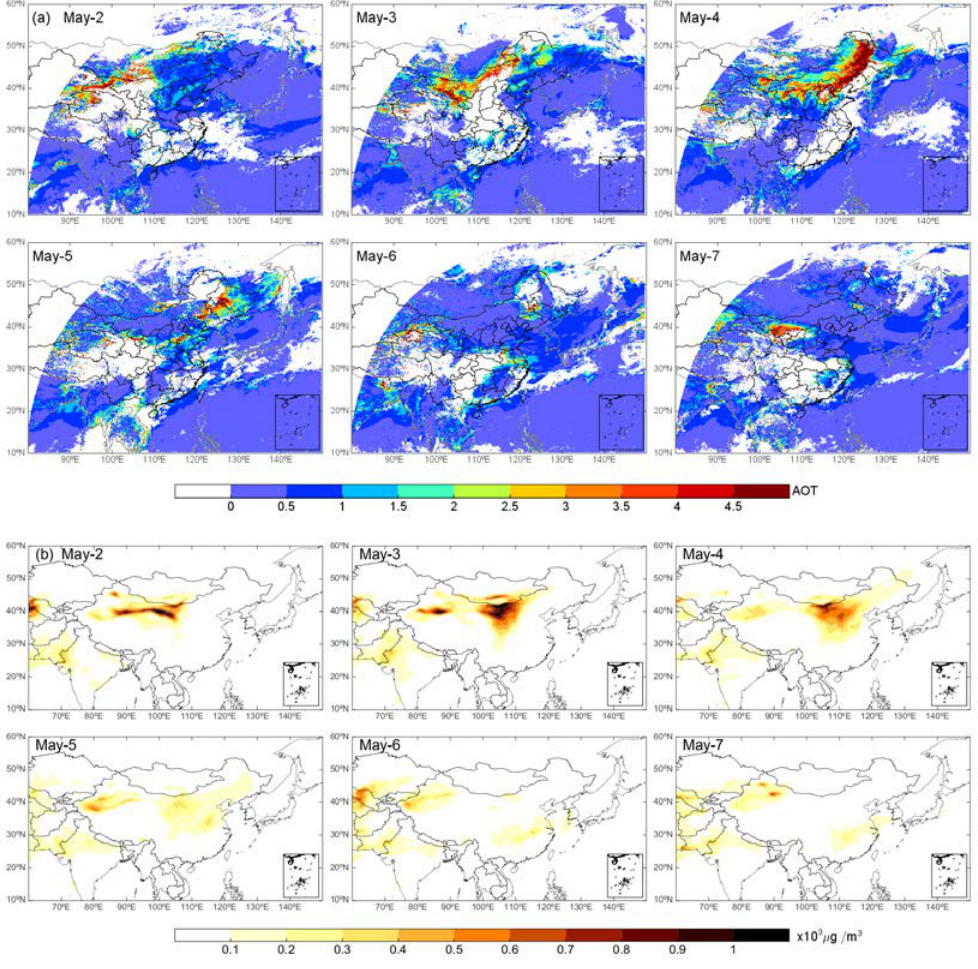
Figure 2. ( a ) Spatial distribution of the AOT (Himawari-8) on 2–7 May 2017; ( b ) spatial distribution the dust column mass concentration (MERRA-2) on 2–7 May of the dust column mass concentration (MERRA-2) on 2–7 May 2017.